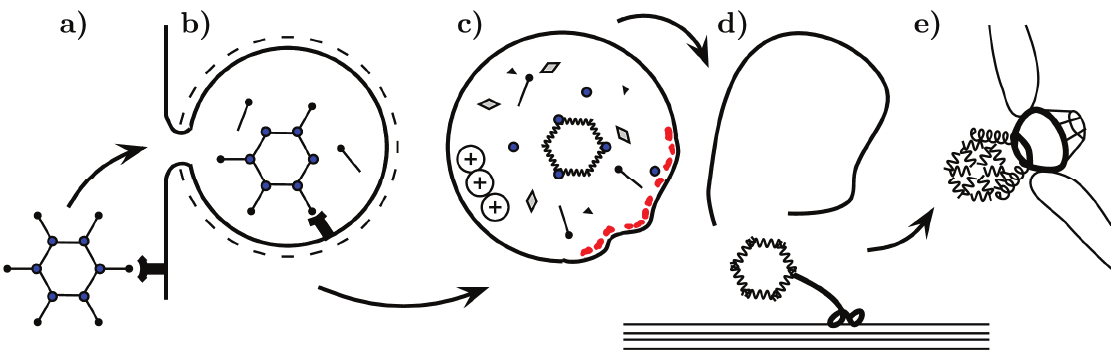
Figure 1. Schematic summary of early stages of adenoviral infection. Fibers interact with CAR receptor ( a ). The cell internalizes the virus via clathrin-coated pit ( b ). The endosomal interior becomes acidic: the viral particle undergoes conformational changes leading to disassembly. Fibers are shed, part of the penton base protein population and other proteins, including protein VI (red), are released ( c ). Protein VI induces vesicle rupture. The partially disassembled viral particle uses microtubules to reach nuclear proximity ( d ) and docks to the nuclear pore complex ( e ), where further disassembly allows the viral genome associated with proteins to reach the nuclear